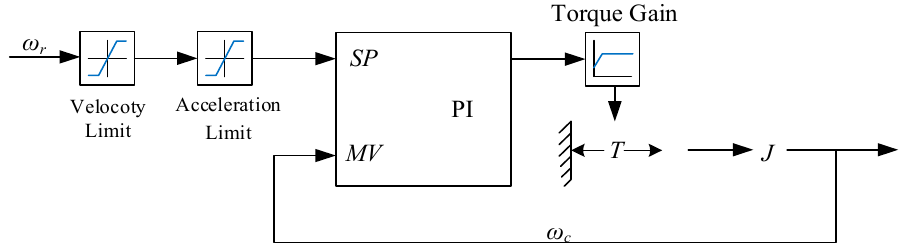
Figure 16. Mathematical model of the motor.